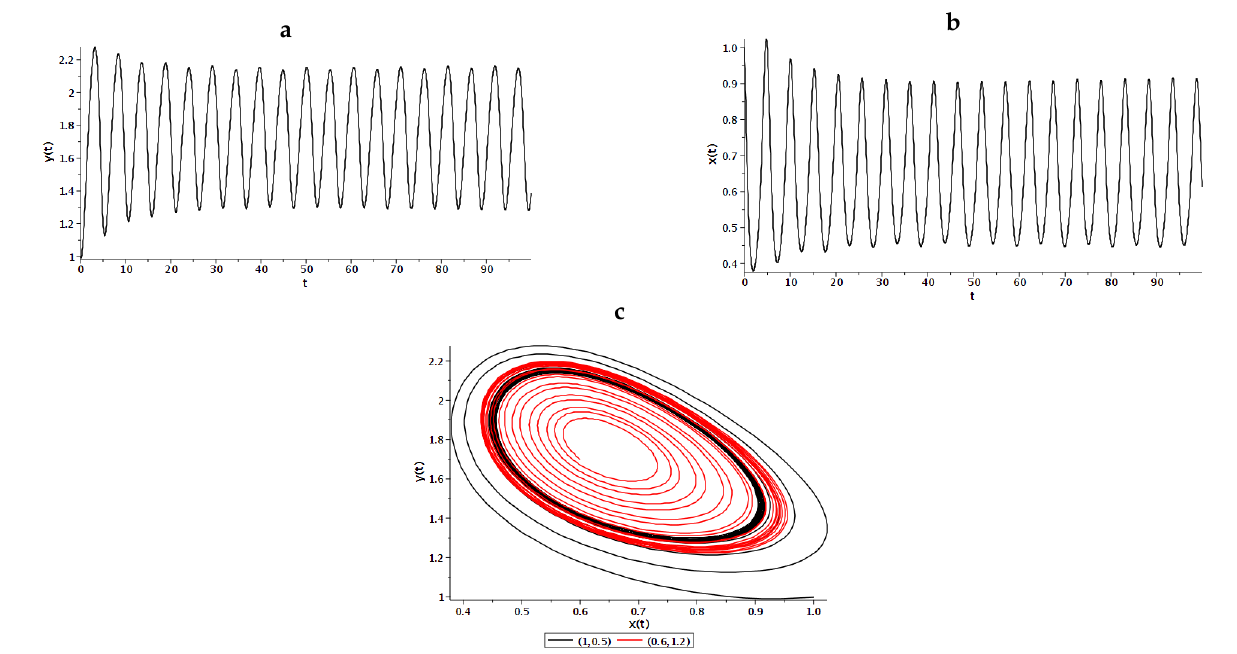
Figure 2. Oscillograms for the concentrations of gs-cracks ( a ) and tr-cracks ( b ); ( c ) phase trajectories constructed under different initial conditions for Example 1.